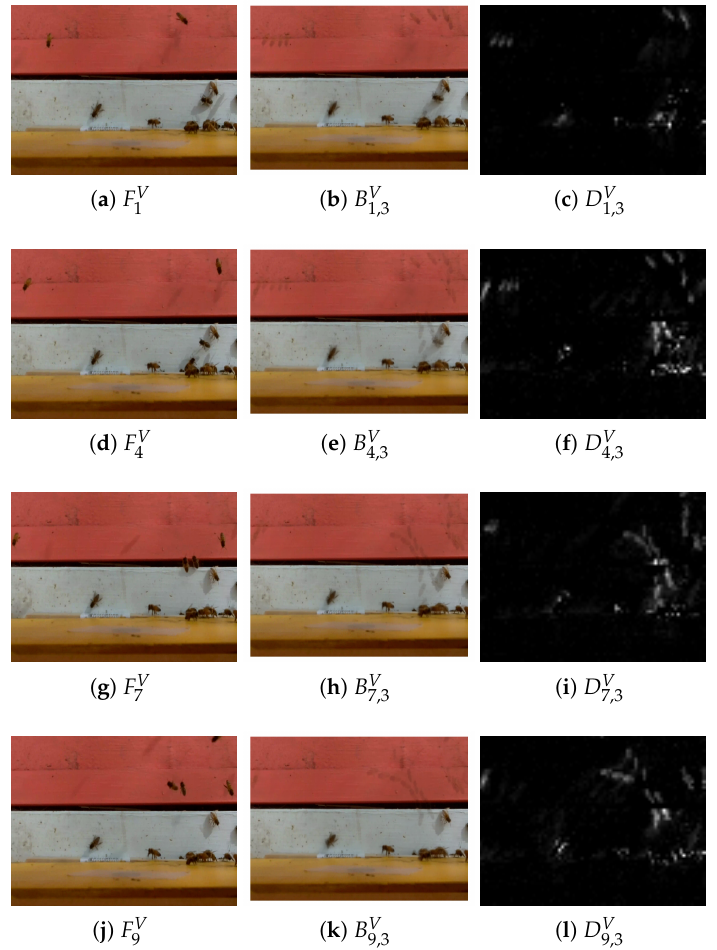
Figure 4. Difference frames D V and corresponding background frames B V